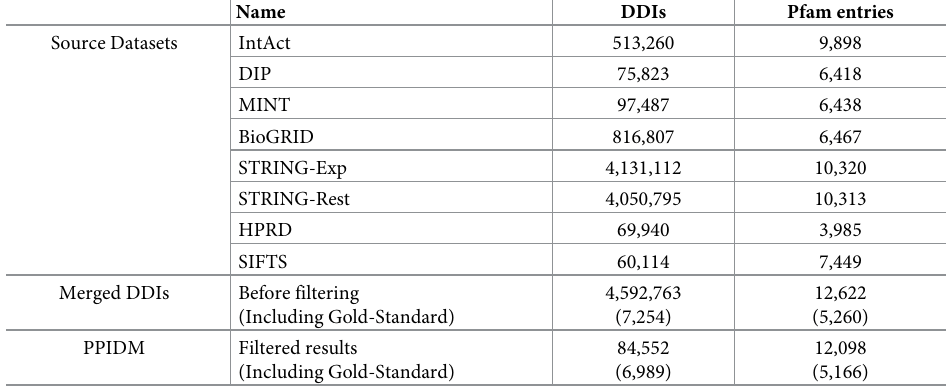
Table 2. Statistics on the source datasets, merged DDIs before filtering and inferred DDIs after filtering at the consensus score